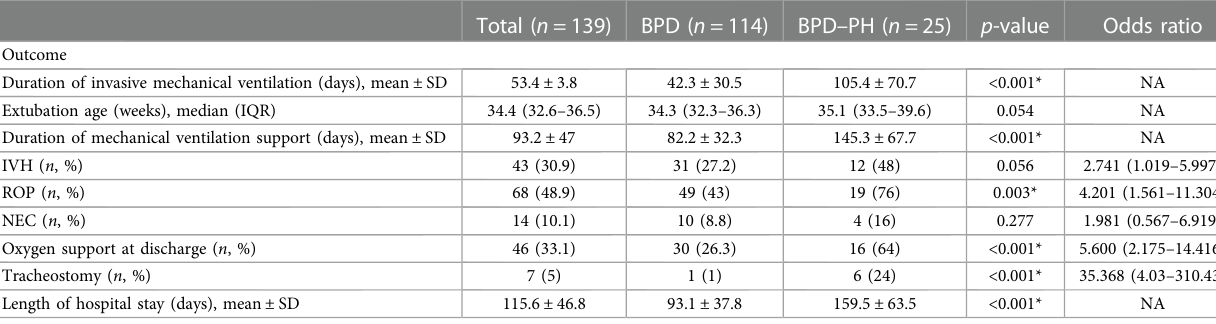
TABLE 3 Outcomes of preterm infants with bronchopulmonary dysplasia with and without pulmonary hypertension. Total ( n = 139) BPD ( n = 114) BPD – PH ( n = 25) p- value Odds ratio